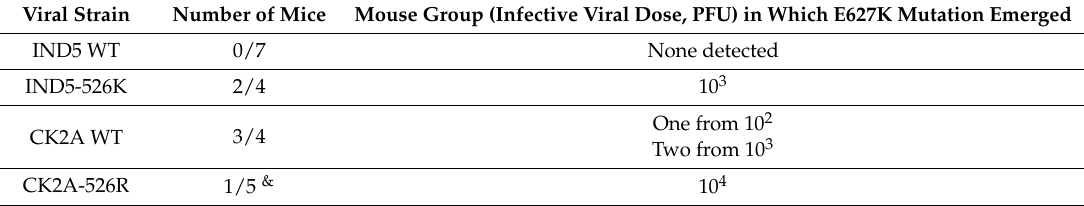
Table 2. E627K adaptive mutations in mice fatally infected with H5N1 virus *.